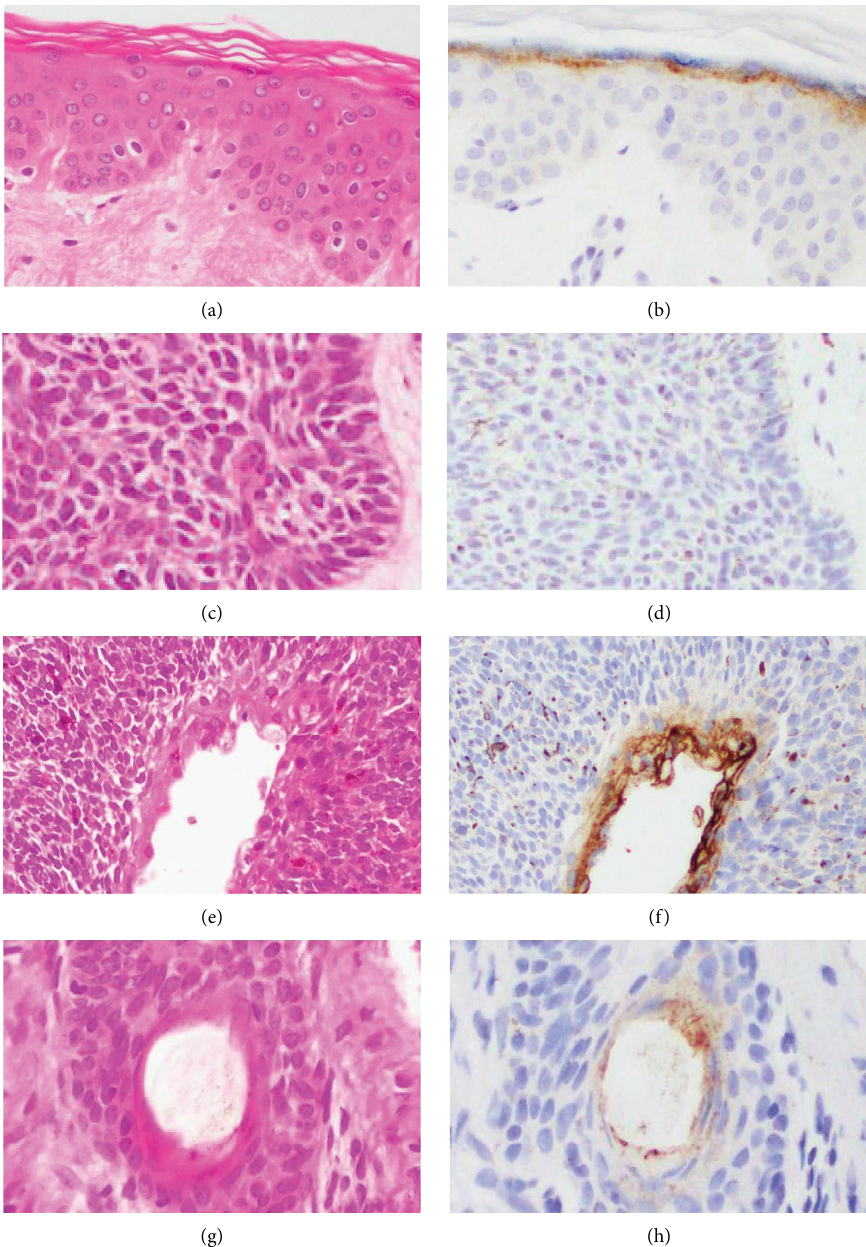
Figure 3: Representative results for claudin 4 (b, d, f, and h) and corresponding HE-stained sections (a, c, e, and g) in normal skin and lower- grade BCC. (a) Microphotograph of normal epidermis. (b) Cytoplasm of epithelia in the granular layer appears positive. (c, e, and g) microphotographs of HE-stained sections in BCC. (c) Neoplastic cells appear uniformly negative. (d) Reactivity is observed in neoplastic cells with diferentiation towards the keratinizing layer. (e) Positivity is limited to neoplastic cell showing follicular diferentiation